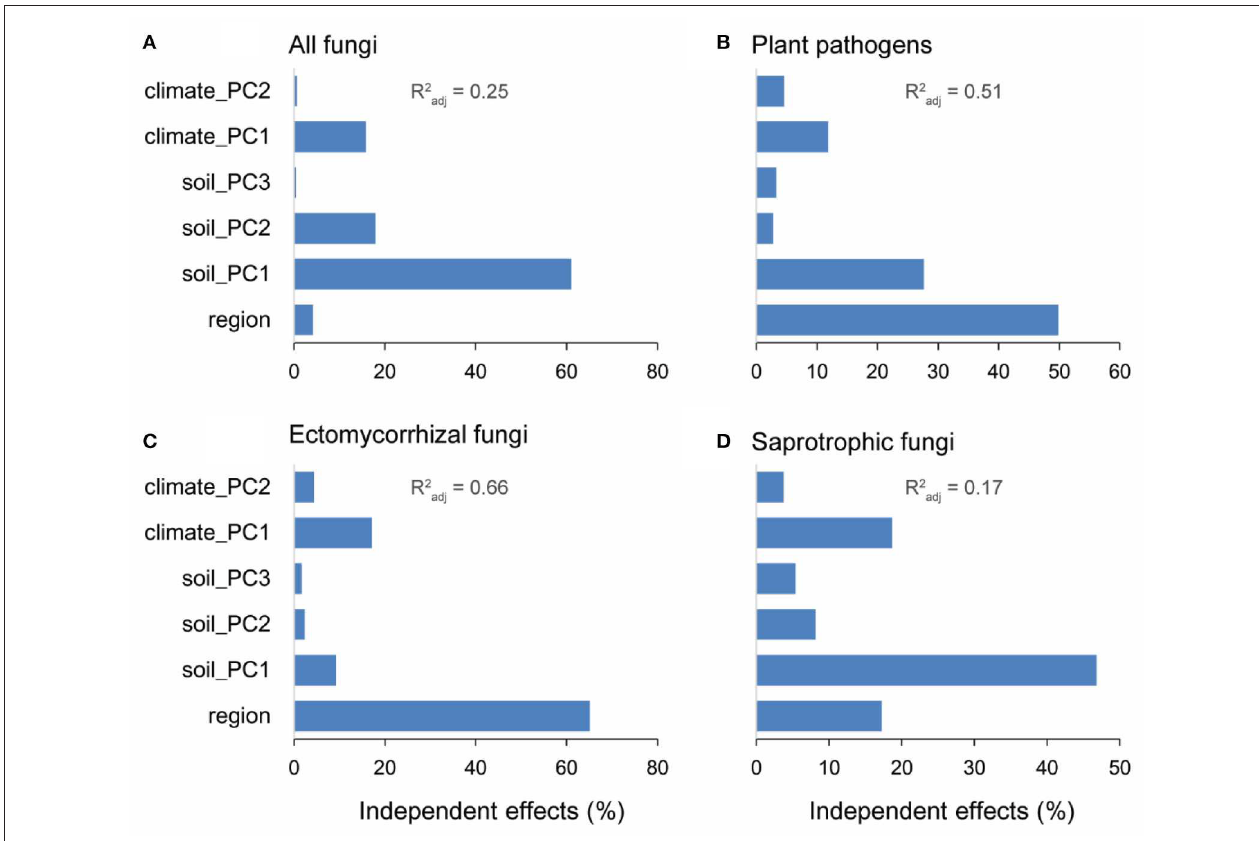
FIGURE 5 | Results of hierarchical variation partitioning of the alpha diversities (OTU level) for all fungi (A) , plant pathogens (B) , ectomycorrhizal fungi (EMF) (C) , and saprotrophic fungi (D) . Forest reserves were grouped into two spatial regions (south and north) based on the diversity patterns of plant pathogens and EMF. Variables of soil properties and climate conditions were subjected to principal components analysis (PCA). The first three PCs (account for more than 60% variation) and first two PCs (account for more than 90% variation) were selected to represent soil properties and climate conditions, respectively. R 2 adj shows the proportion of explained variation of alpha diversity by multiple regression with these six